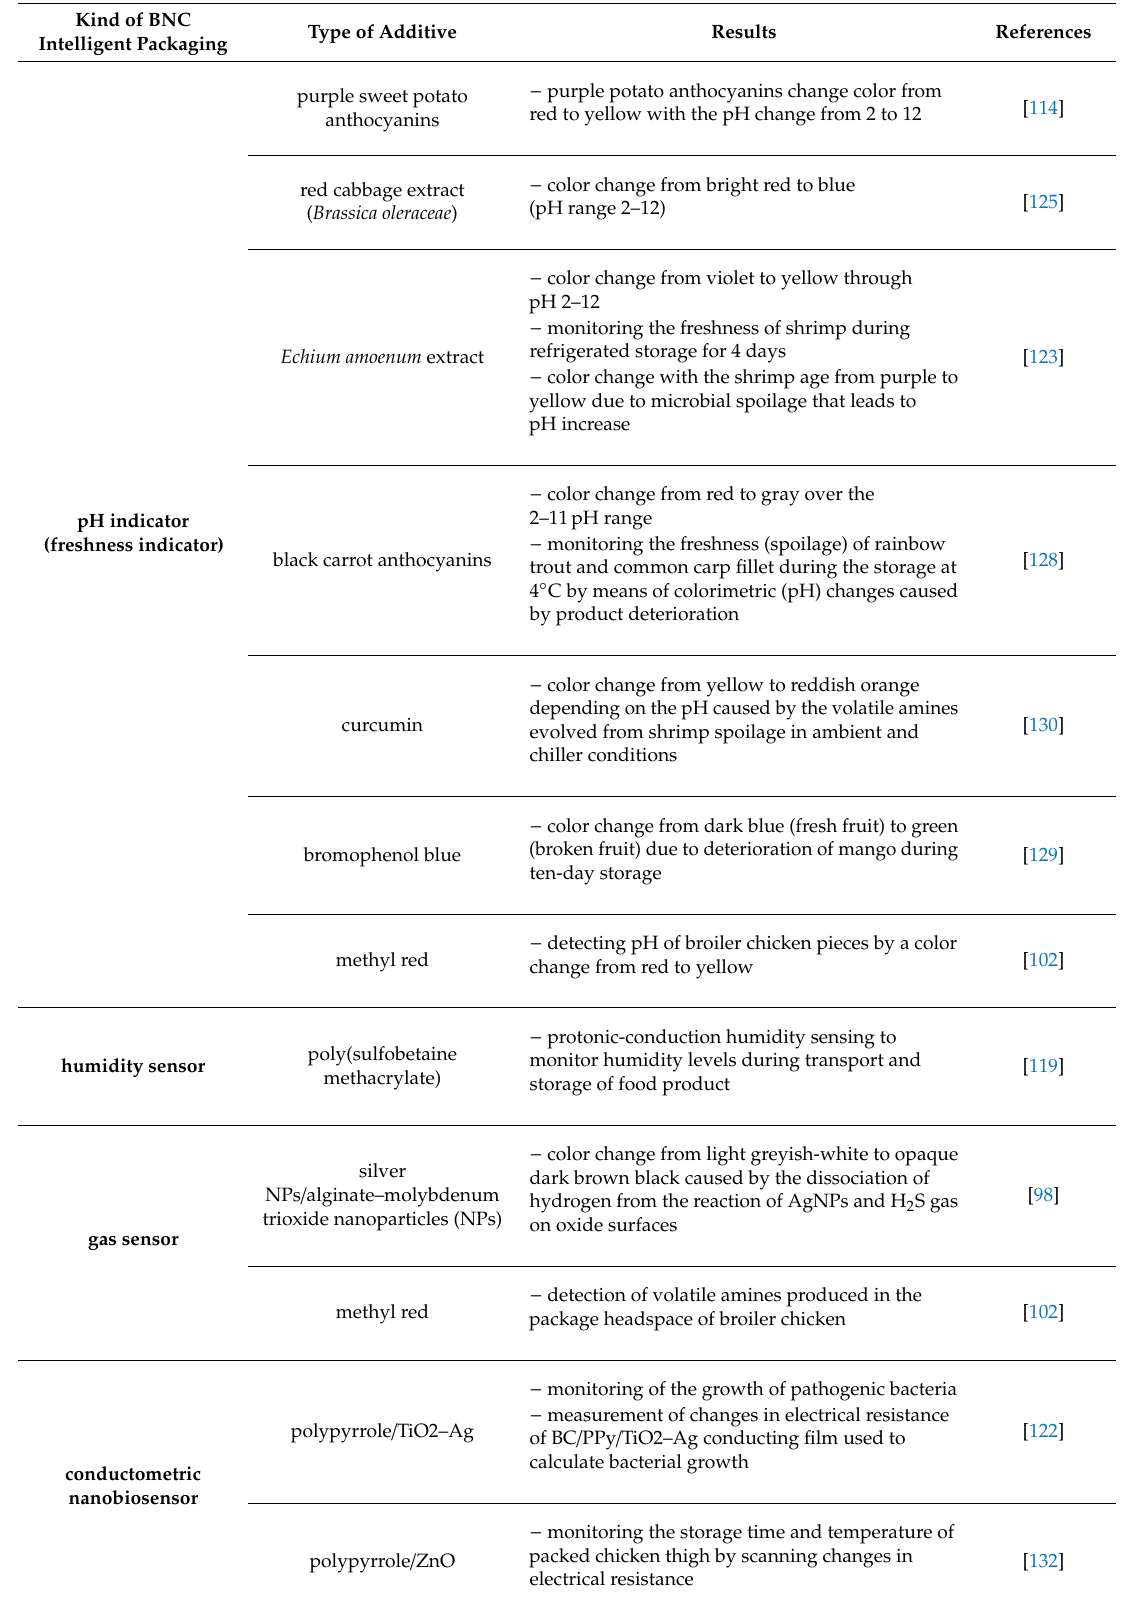
Table 2. The overview of BNC-based intelligent packagings and their e ff ect on foodstu ff . Kind of BNC Intelligent